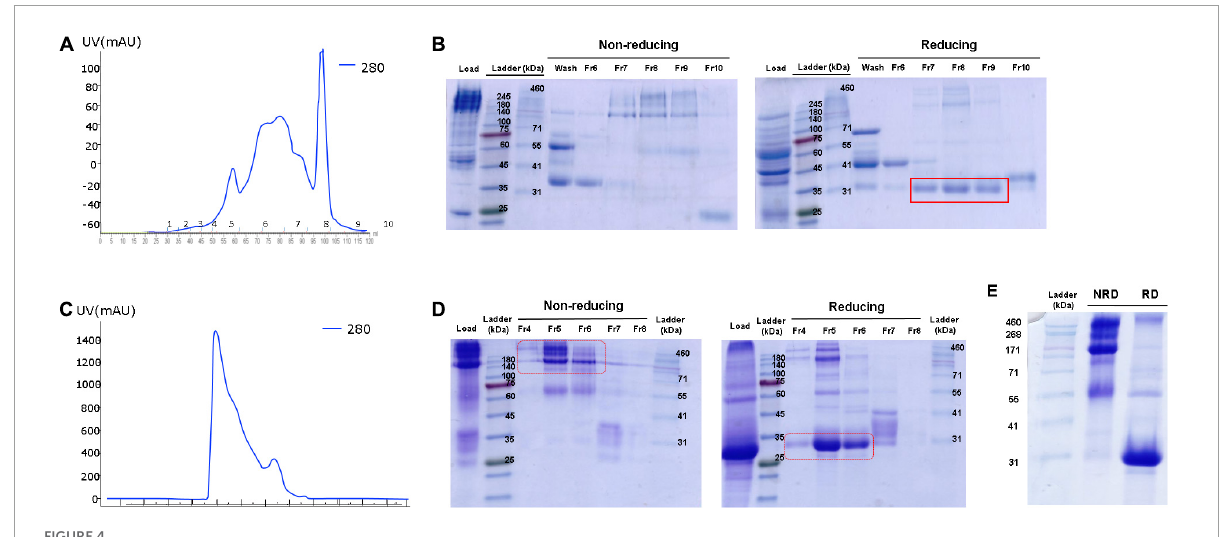
FIGURE4 Purification of ADPN from OVA ADPN KI chicken egg white. (A) Elution profile observed at 280 nm of the purification of ADPN by Hitrap Q hp column. (B) Non-reducing and reducing SDS-PAGE gel after Hitrap Q hp column purification. (C) Elution profile observed at 280 nm of the purification of ADPN by Superdex G75 analytical size exclusion chromatography. (D) Analysis of the ADPN on 10% SDS-PAGE gel following purification by size exclusion chromatography. (E) The purified ADPN was loaded on the 10% SDS-PAGE gel. NRD, non-reducing condition; RD, reducing